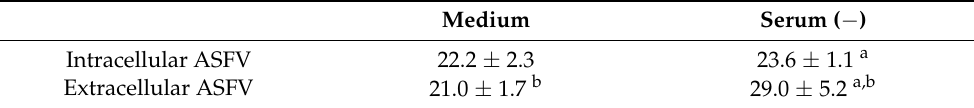
a,b The differences between the treatments with the same superscripted letters were statistically significant ( p <